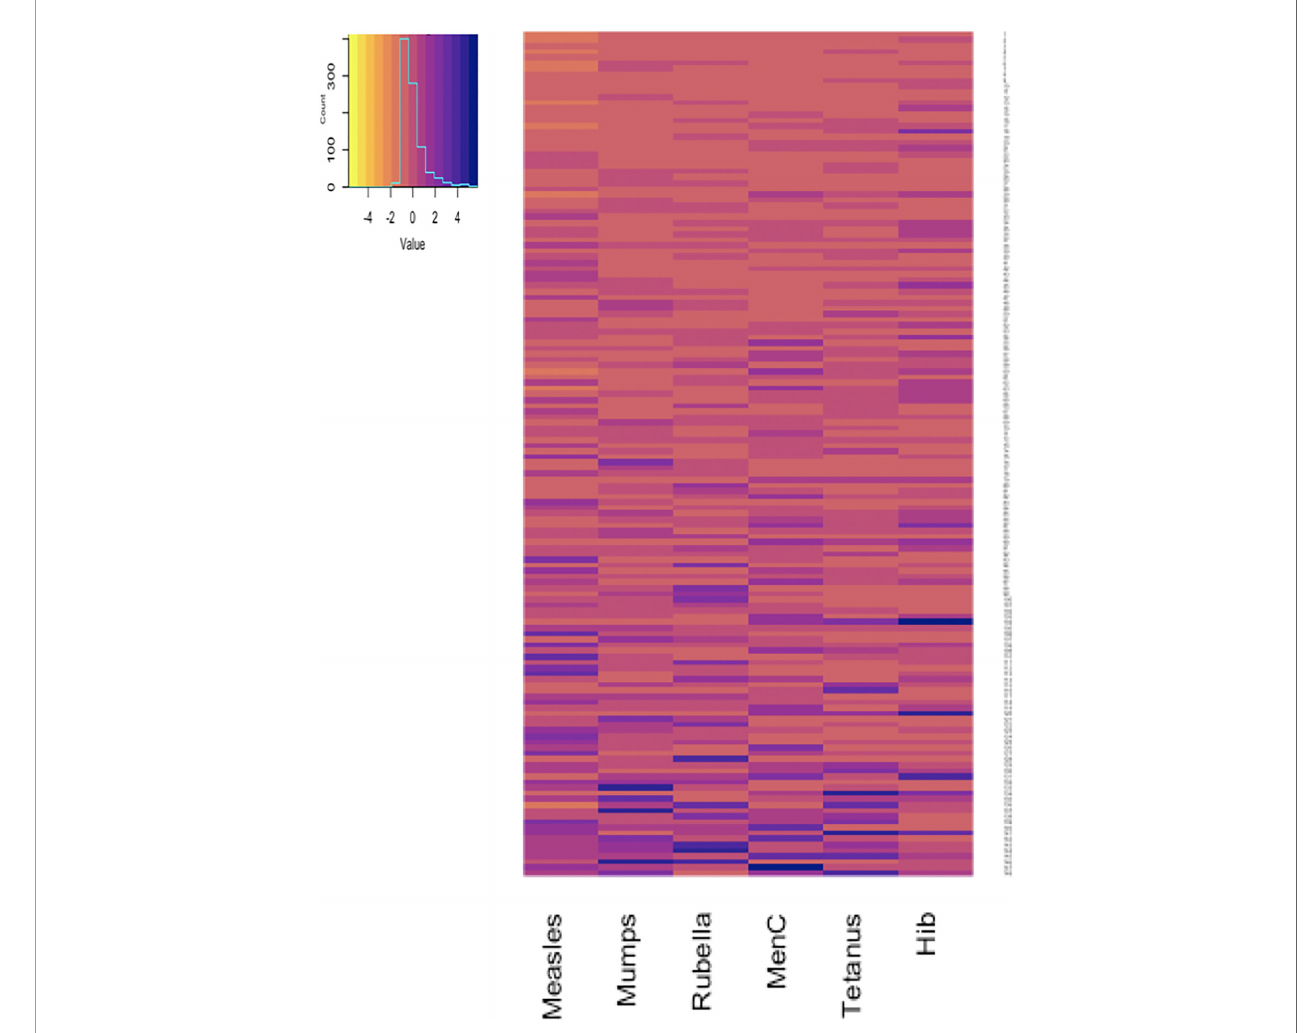
FIGURE 3 | Antibody responses to 12-month vaccinations measured one month after vaccination in 148 participants. Each row depicts one participant with the colour in each column representing the ‘ scaled ’ [(individual vaccine response - mean vaccine response)/standard deviation] vaccine antibody response in that individual. MenC, Meningococcus C; Hib, Haemophilus in fl uenzae type